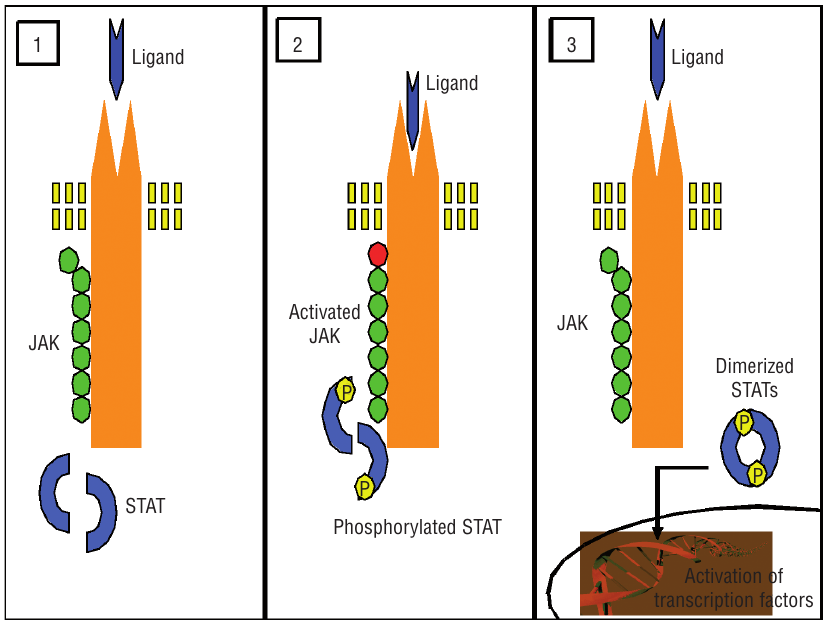
Figure 4. Steps of JAK-STAT